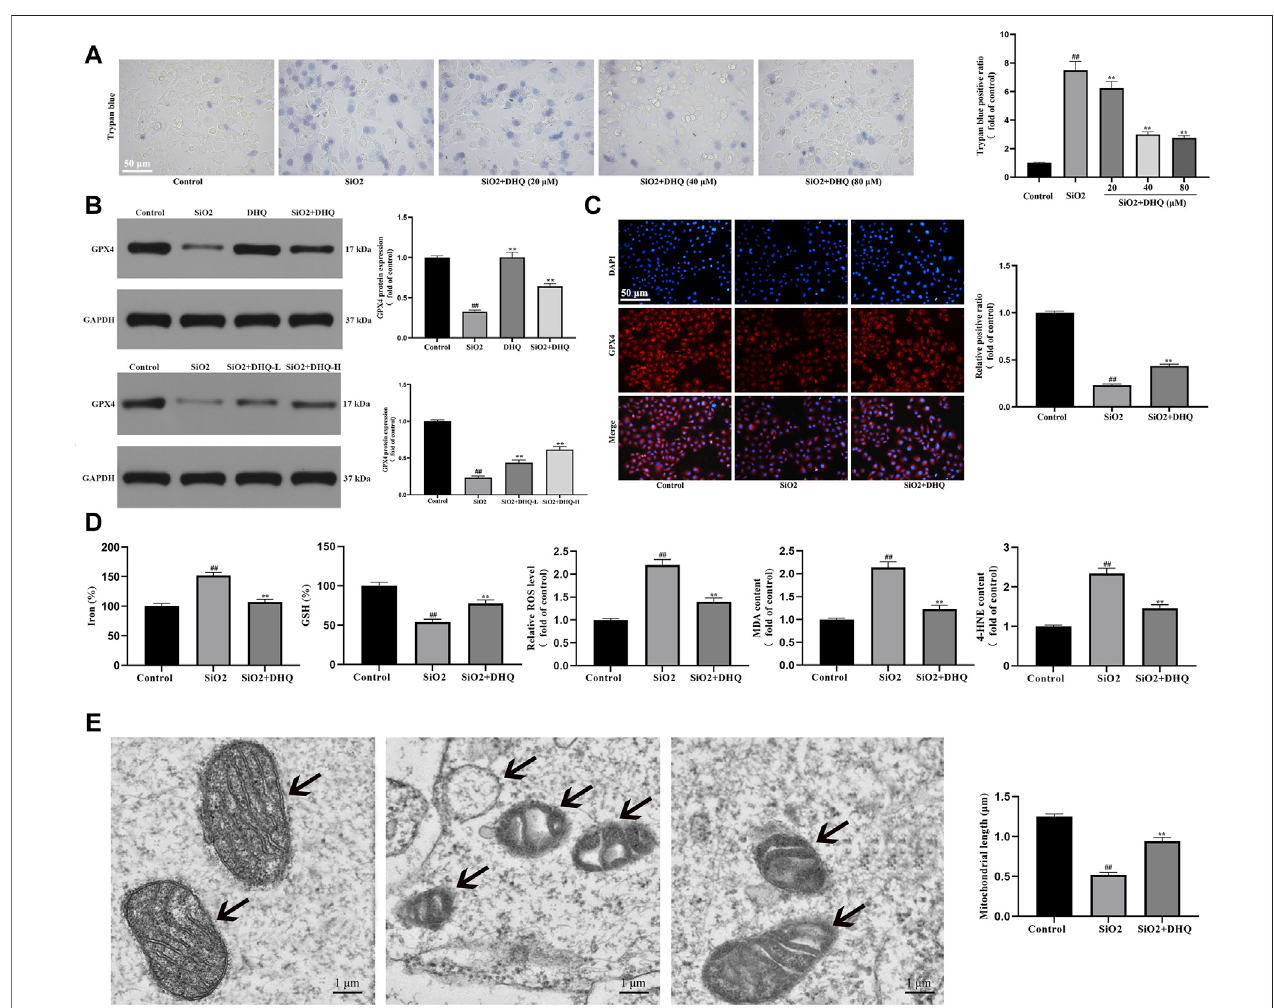
FIGURE3| DHQsuppressedferroptosisofactivatedHBEcells invivo and invitro (A) Representativeimages( ✕ 200)oftrypanbluestainingforevaluatingcelldeath. Bar = 50 μ M. (B) The protein expressions of GPX4 in HBE cells and lung tissues were determined by western blotting. (C) Representative pictures ( × 200) of immuno fl uorescenceanalysisofGPX4inHBEcellsweredeterminedbywesternblotting.Bar=50 μ M. (D) Thelevelsofmajorbiomarkersofferroptosis(iron,GSH,ROS, MDA, and 4-HNE) in HBE cells were detected. (E) The morphological changes of mitochondria were observed by transmission electron microscopy and mitochondrial length was measured. Data are shown as mean ± SD ( n = 3). # p < 0.05, ## p < 0.01 vs. the control group; * p < 0.05, ** p < 0.01 vs. the SiO 2